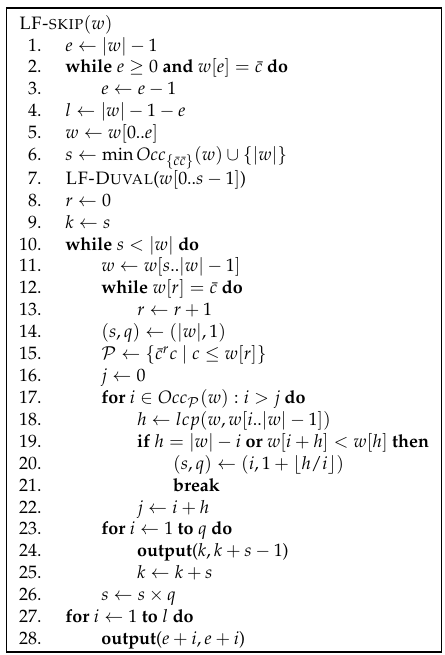
Figure 2. The algorithm to compute the Lyndon factorization that can potentially skip